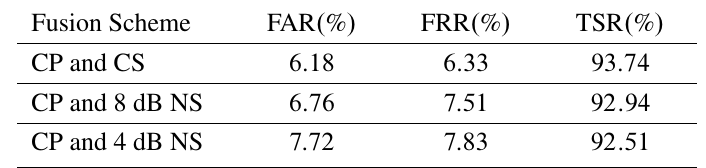
Table 5. Verification rate of match score level fusion of clean palmprint using ICA I MM with speech (clean and noisy).